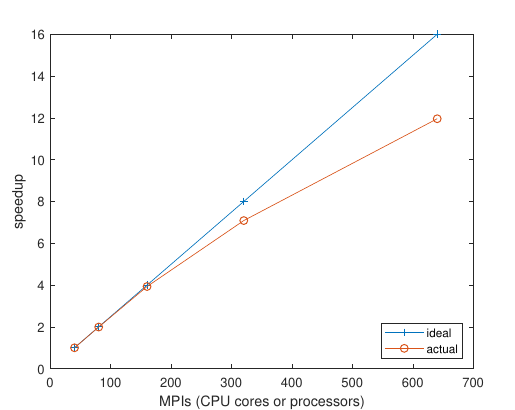
Figure 12. The speedup for the known endpoint example with 160 ensemble members.